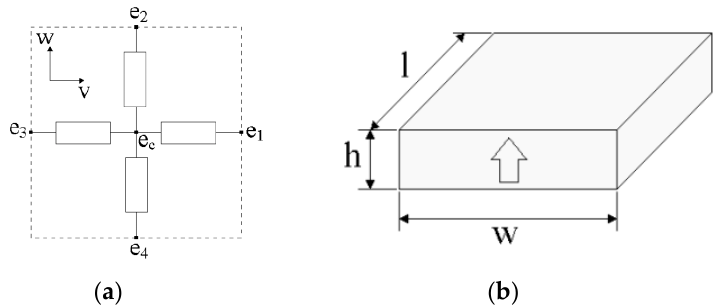
Figure 10. ( a ) Reluctance element used for 2D problems; ( b ) the rectangular parallelepiped PM region.